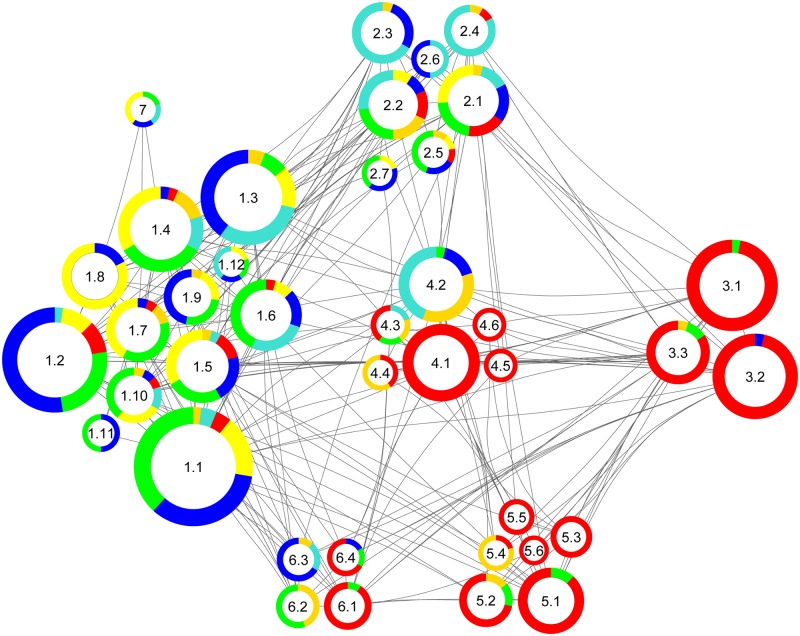
Subcommunity structure of the network based on Fig 3B.The color code corresponds to the pie chart diagram (cf. Fig 1E). The size of the rings corresponds to the respective number of proteins. Communities (1–7) were subdivided into the following functional clusters (e.g. 1.1–1.12): 1.1 Calcium Signaling, 1.2 Presynaptic Membrane, 1.3 Exocytosis, 1.4 Cytoskeleton Organization, 1.5 Membrane Assembly, 1.6 G-Protein Signaling, 1.7 Organelle Transport, 1.8 Actin Organization, 1.9 Synapse Assembly, 1.10 Membrane Regulation, 1.11 Inhibitory Regulation, 1.12 Vesicle Priming, 2.1 Membrane Trafficking, 2.2 Vesicle Budding, 2.3 Endocytosis, 2.4 Proton Transport, 2.5 Phospholipid Metabolism, 2.6 Vesicle Organization, 2.7 Membrane Organization, 3.1 Electron Transport Chain, 3.2 Energy Metabolism, 3.3 Stress Defense, 4.1 Cellular Respiration, 4.2 Glycolysis, 4.3 Guanine Metabolism, 4.4 Glycerol Metabolism, 4.5 Mitochondrial Metabolism, 4.6 Mitochondrial Assembly, 5.1 Fatty Acid Catabolism, 5.2 Neurotransmitter Metabolism, 5.3 Amino Acid Catabolism, 5.4 Metabolism, 5.5 Fatty Acid Metabolism, 5.6 Mitochondrial Targeting, 6.1 Mitochondrial Protein Trafficking, 6.2 Heatshock Response, 6.3 Neuronal Regulation, 6.4 Protein Folding, 7 Functional Dynamics.